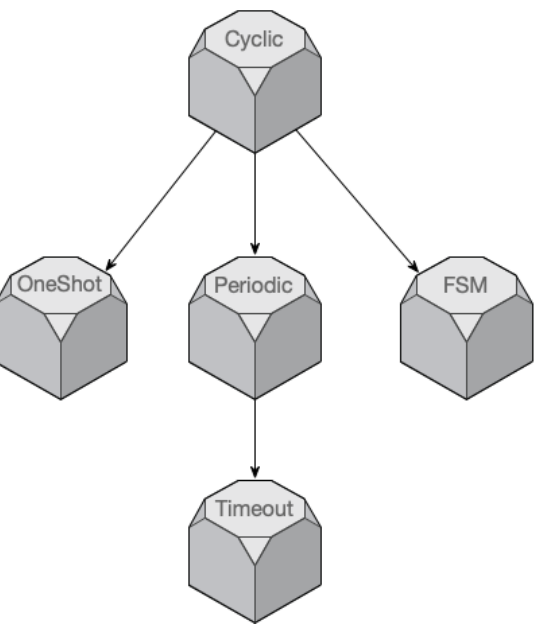
Figure 5. SPADE’s behavior